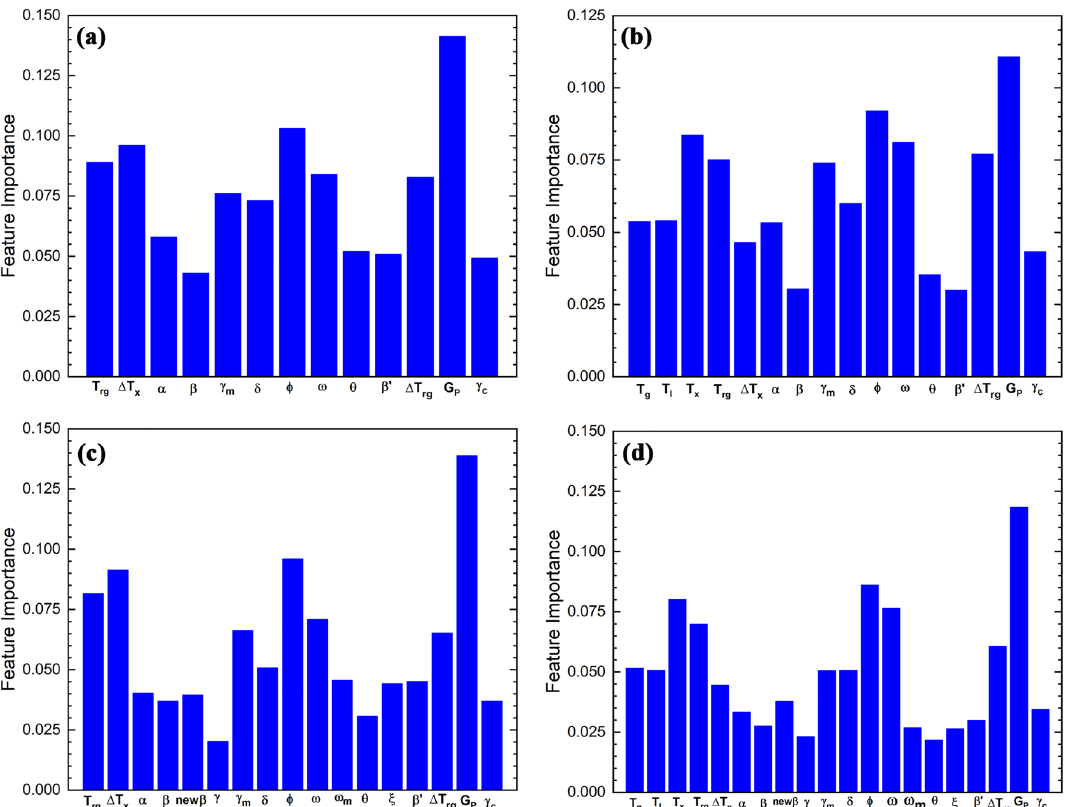
Figure 3. The feature importance of the model with ( a ) 13 selected features, ( b ) 13 selected features and added characteristic temperatures, ( c ) 17 selected features, and ( d ) 17 selected features and added characteristic